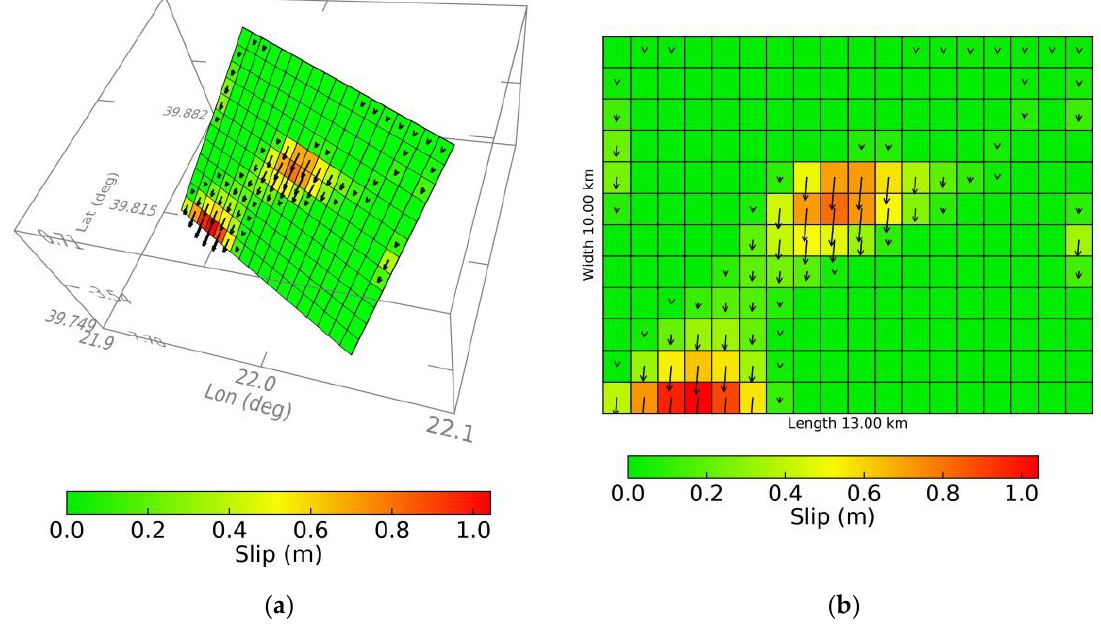
Figure 22. Modeled geodetic seismic fault for the earthquake of 12 March 2021 in ( a ) 3D illustration and ( b ) vertical profile along strike (ESE–WNW).